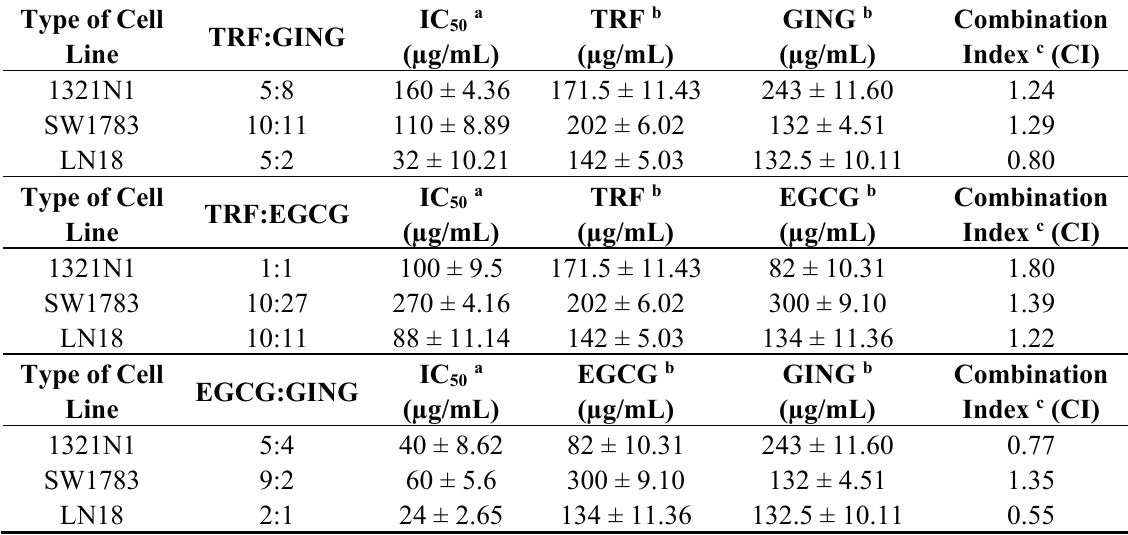
Table 2. The ratio of combined compounds at a growth inhibition of 50% (IC 50 ) on glioma cancer 1321N1, SW1783 and LN18 cells and the combination index (CI) for each combination. The data are the average of three independent experiments.